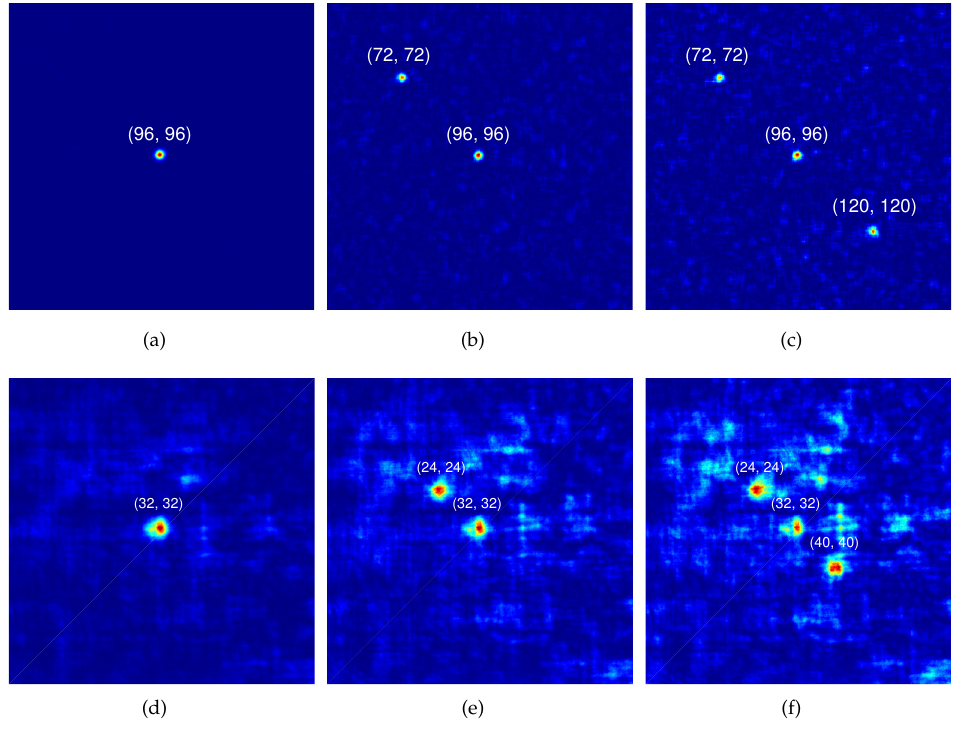
Figure 6. Observation plane intensity patterns ( a – c ) are computer simulations of the focal-plane system and ( d – e ) are laboratory results of the imaging system with the 600 grit aluminum sample. Above each spot are the (row, column) coordinates of the given observation plane segment. Phase maps generated by the RM (reflection matrix) are used to refocus light to single or multiple segments in the observation plane. ( a ) a simulated single-segment enhancement of η = 348 over background speckle; ( b ) simulation of two foci optimized simultaneously at ( 72,72 ) and ( 96,96 ) with enhancements of η = 47 and 56, respectively; ( c ) simulation of three foci generated with increased background speckle at ( 72,72 ) , ( 96,96 ) , and ( 120,120 ) with enhancement values of η = 26, 32, and 29, respectively; ( d ) demonstrated single-segment enhancement of η = 18 over background speckle using the imaging system with the 600 grit aluminum sample ( e ) two segments are optimized simultaneously, measured enhancement for both foci is η = 10; ( f ) three foci are generated with increased background speckle at ( 24,24 ) , ( 32,32 ) , and ( 40,40 ) , enhancement values are η = 7, 6, and 7,